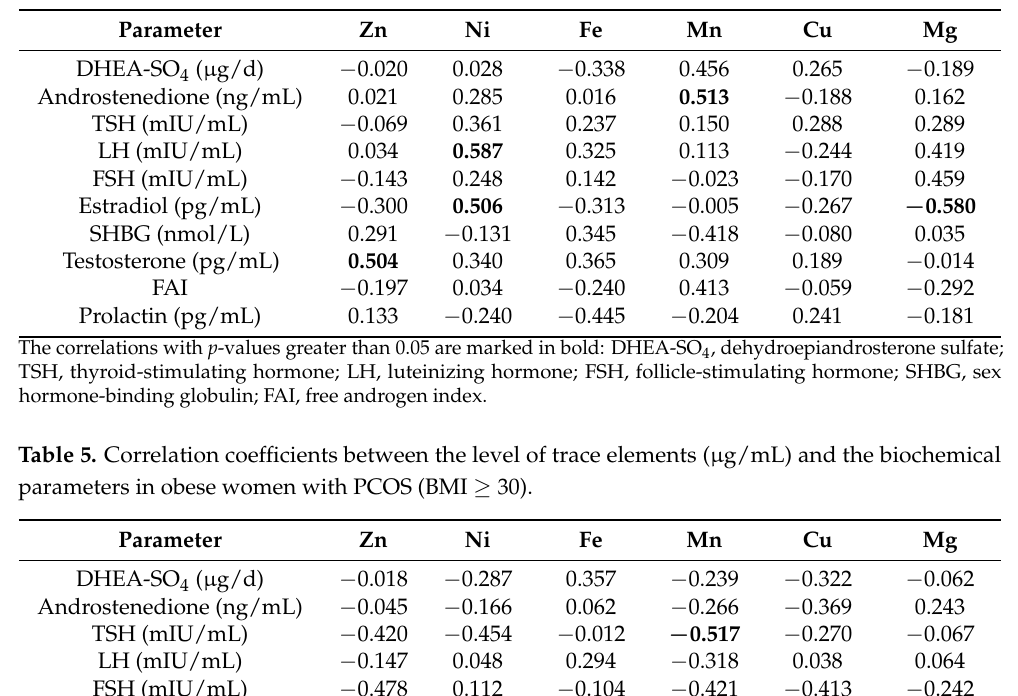
Table 4. Correlation coefficients between the level of trace elements ( µ g/mL) and the biochemical parameters in nonobese women with PCOS (BMI < 30).